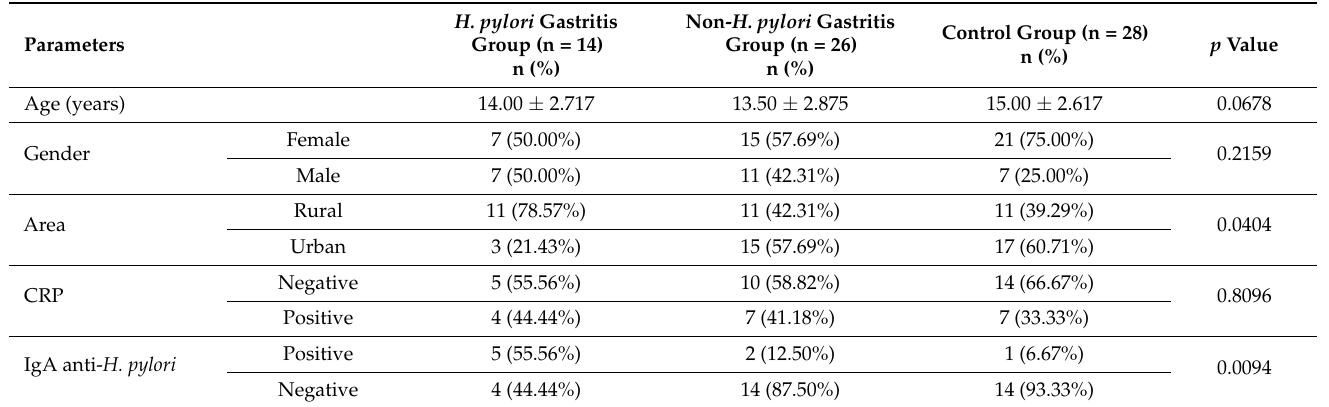
Table 1. Comparison of three groups according to age, gender, area and